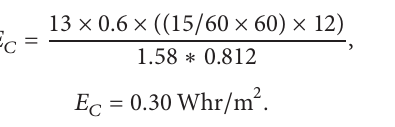
, and the current track